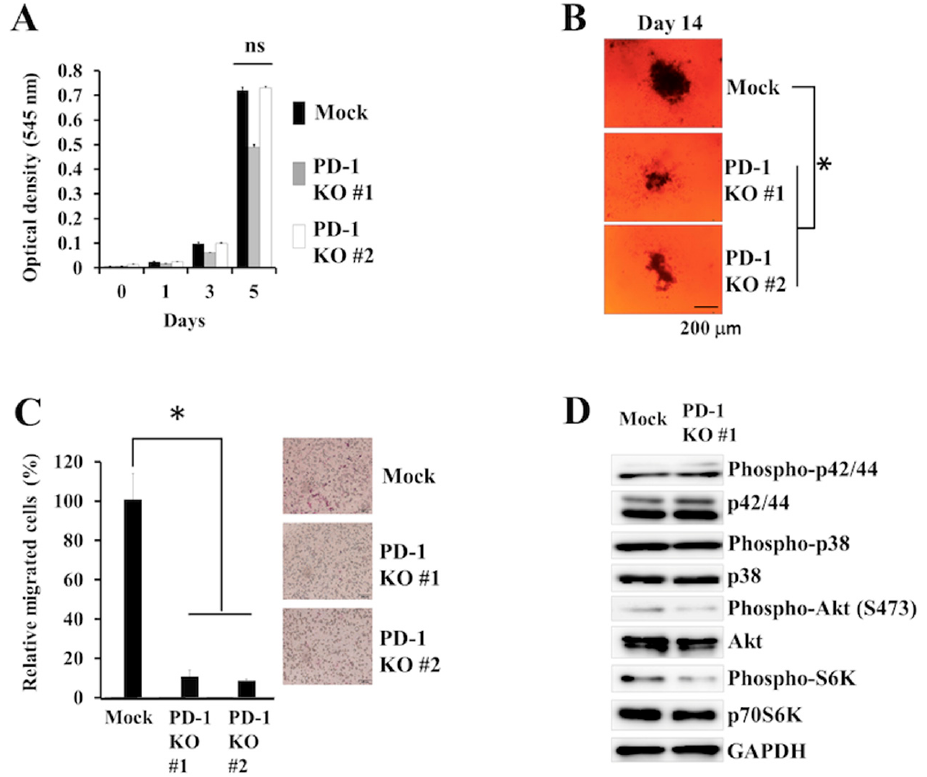
Figure 3. Effects of PD-1 expression on growth, migration, and cellular signaling of VAL cells. ( A ) MTT assay showing cell proliferation in VAL/mock and VAL/PD-1-KO cell clones. ( B ) Colony formation of VAL/mock and VAL/PD-1-KO cell clones on soft agar via a colony formation assay. ( C ) Comparison of the cell migration activity of VAL/PD-1-KO with VAL/mock cell clones. ( D ) Western blotting analyses for phosphorylation level of p42/44, p38, Akt, and S6 kinase in VAL/mock and VAL/PD-1-KO cell clones. ns, not significant; * p < 0.005. PD-1, programmed death-1.